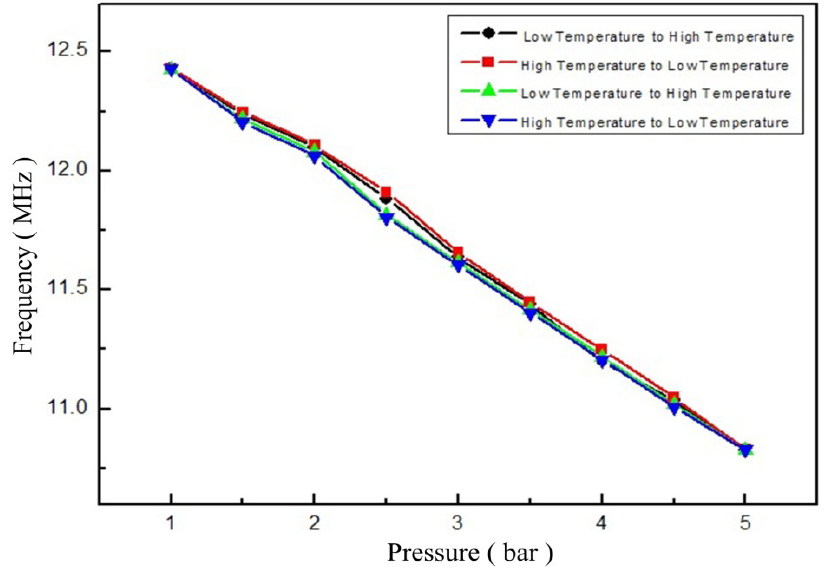
Figure 14. Measured resonant frequency at 600 °C versus